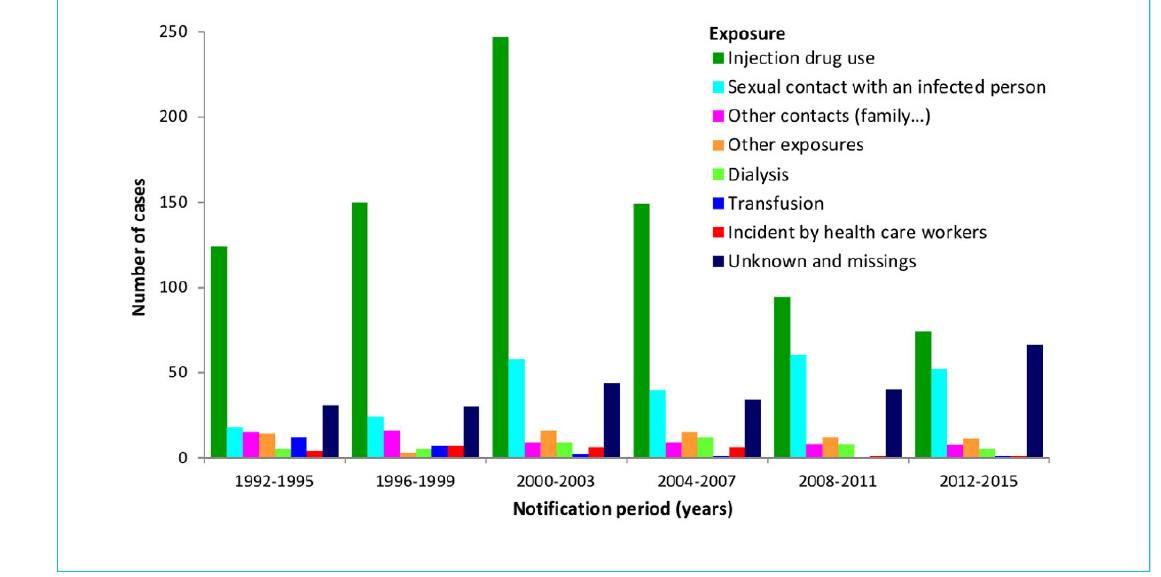
Figure 4: Numbers of acute hepatitis C virus cases by exposure and notification period, Switzerland, 1992-2015. Other exposures cover espe- cially exposure by medical injections, surgery, dental care, tattooing or perinatal